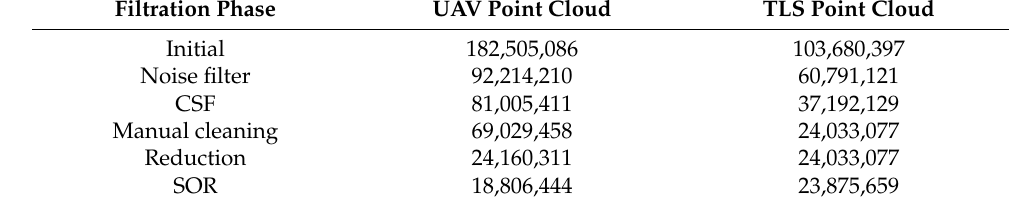
Table 4. Number of points in the individual clouds, after each filtration stage.